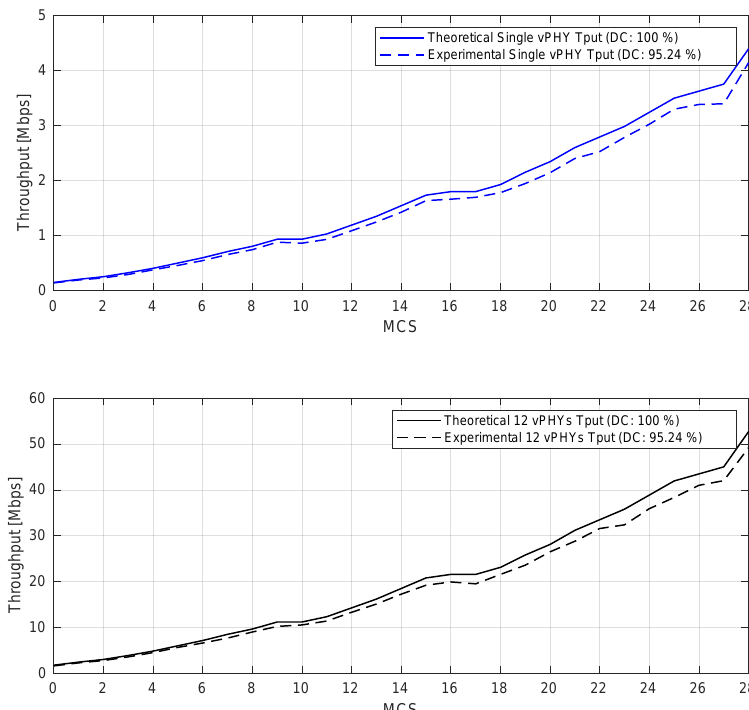
Figure 20. Prototype’s throughput for single and 12 vPHYs over different MCS values.